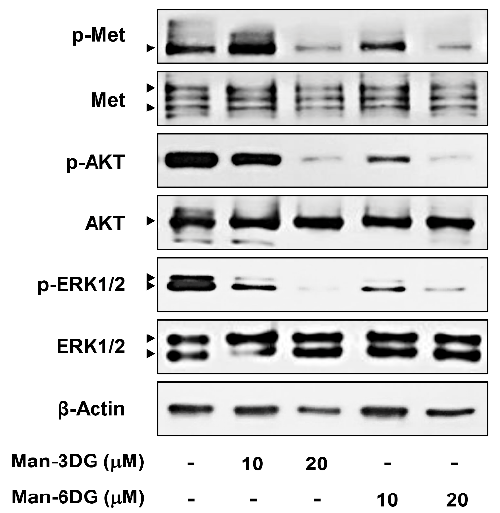
Figure 7. The effects of α -mangostin glycosides on c-Met signaling pathway in Hep3B cells. The cells were treated with Man-3DG and Man-6DG (10 and 20 µ M) for 24 h, and the protein levels were detected through western blot analysis using specific antibodies. The levels of β -actin were used as an internal control.